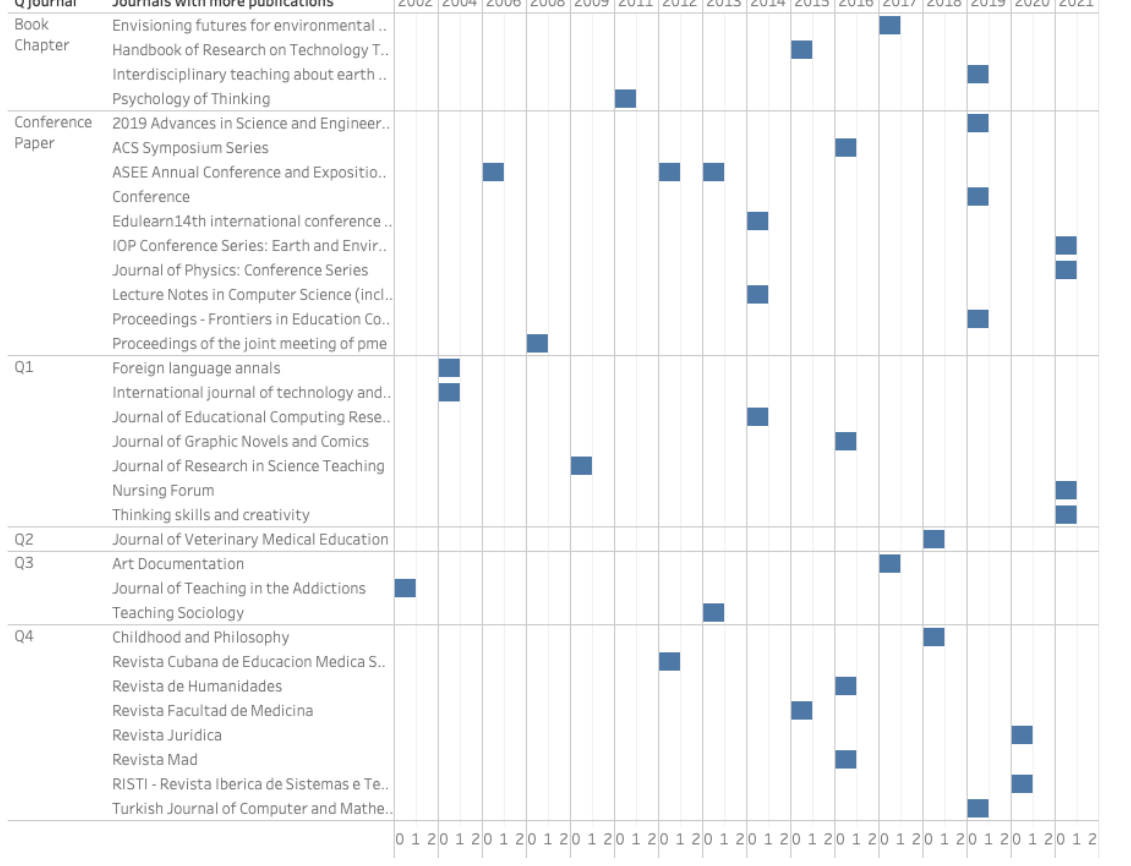
Figure 4. Years, journals, and quartiles of analyzed papers.